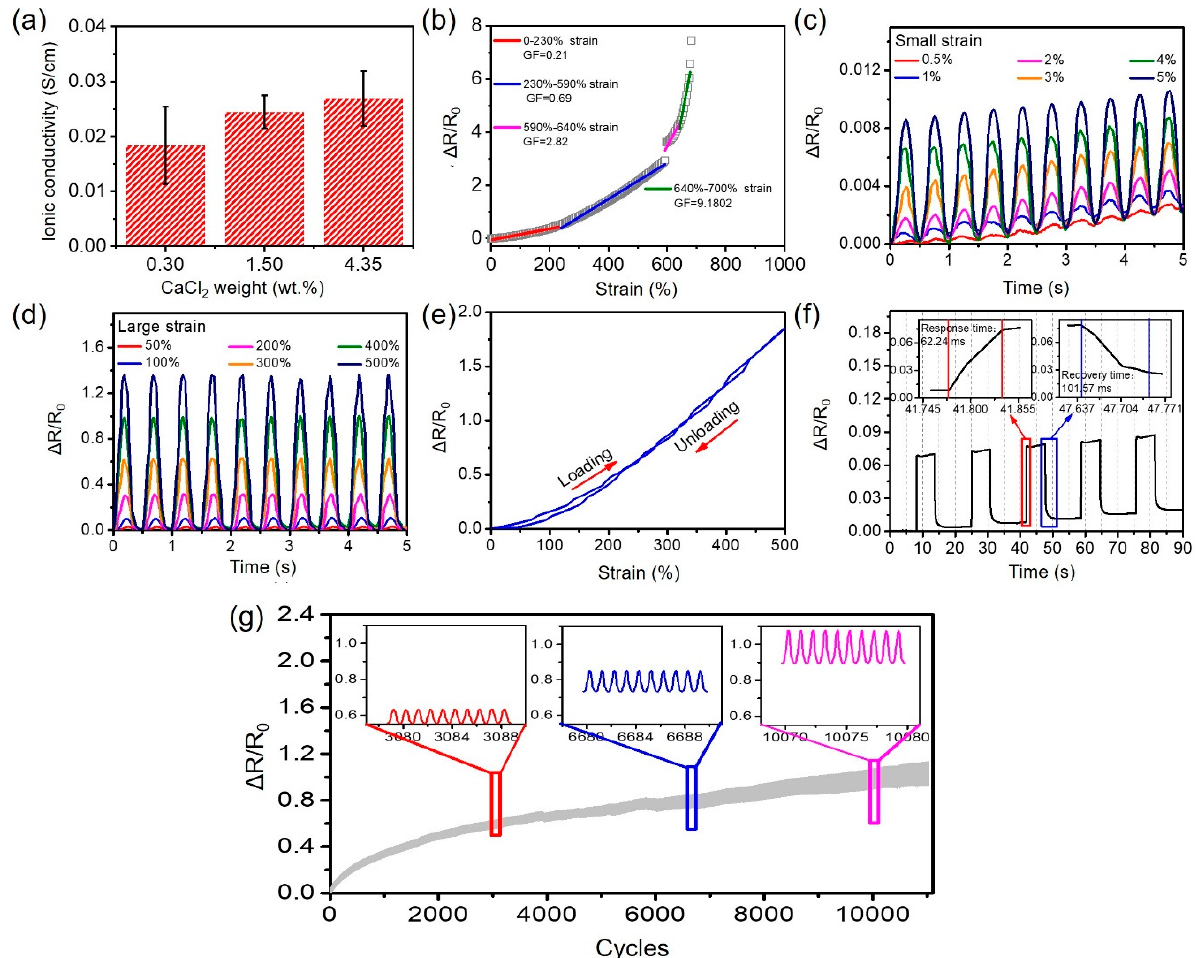
Figure 4. Electromechanical performances of CMCS-Ca 2+ /PAAm/PNMA hydrogels and their strain sensors. ( a ) Con- ductivity value as a function of different CaCl 2 addition content; ( b ) relative resistance change and linear fit of the strain sensors made of CMCS-Ca 2+ /PAAm/PNMA hydrogels as a function of strain; ( c , d ) plots of ∆ R/R 0 vs. time with stretching– relaxation under different strains from 0.5% to 500%. ( e ) The ∆ R/R 0 curves of CMCS-Ca 2+ /PAAm/PNMA hydrogel under the 0% to 500% applied strain at the stretching rate of 100 mm/min. ( f ) Response and recovery time of the CMCS- Ca 2+ /PAAm/PNMA hydrogel sensors. ( g ) The resistance response of the CMCS-Ca 2+ /PAAm/PNMA hydrogel sensors over 11,000 stretching–relaxation cycles at 100% strain under 2000 mm/s tensile Table 1. Brief summary of results reported on conductive hydrogels.